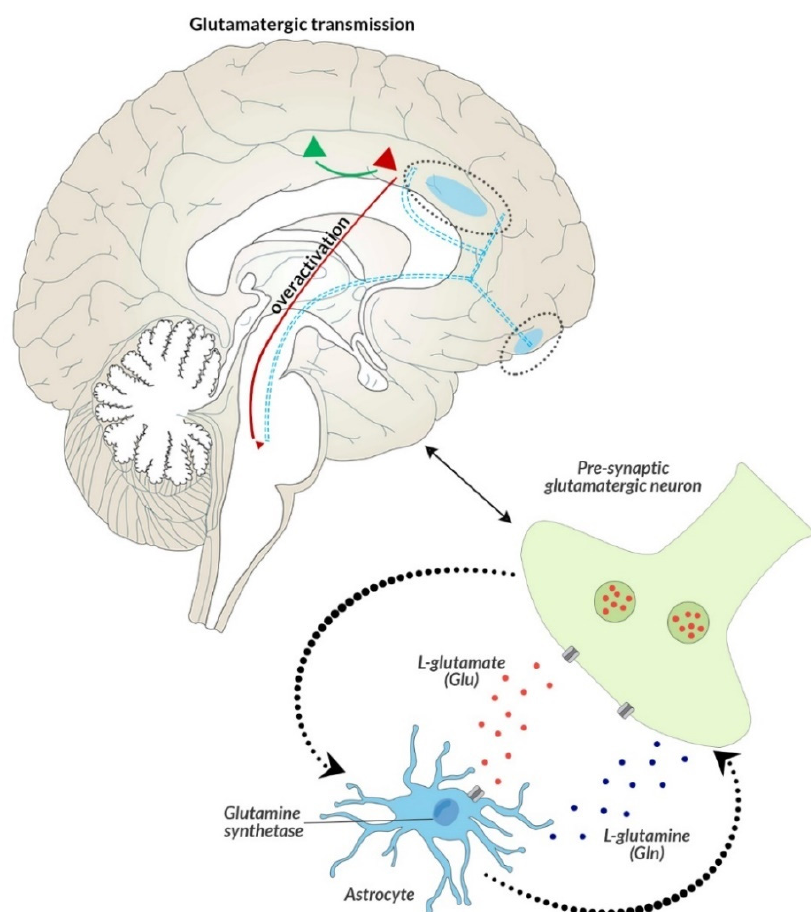
Figure 1. Potential mechanism explaining the occurrence of negative symptoms, and the developing resistance to classical neuroleptics due to the glutamatergic hypothesis and the NMDA receptor hypofunction. In addition to the glutamate projection pathway in the cortical brain stem, which is associated with the primary GLU neuron, the GABA interneuron, and the secondary GLU neuron, additional synapses in the midbrain with another GABA interneuron that targets neuronal DA projections that return to the frontal cortex, are involved in the projection of negative symptoms in schizophrenia. During normal psychiatric functioning, this circuit is balanced and sufficient DA reaches the frontal cortex without negative symptoms. However, when the pathway is modified with the formation of an additional GABA interneuron (originally: GLU-GABA-GLU-D; after modification: GLU-GABA-GLU-GABA-DA), this change might be associated with the appearance of negative symptoms. In the case of generating positive symptoms, glutamate from the primary GLU neuron reaches hypofunctional NMDA receptors located on the primary GABA interneuron, whose tone disappears in the absence of GLU stimulation and the secondary GLU neuron becomes hyperactive again. In contrast to the mechanism associated with the generation of positive symptoms, the main issue concerns the secondary GLU neuron, which hits another GABA interneuron, which, through a higher than normal GLU signal, releases much higher concentrations of GABA. This results in the inhibition of the final pathway of DA neurons derived from the midbrain and their lower release. This mesocortical DA pathway is now active and does not provide adequate amounts of DA in the frontal cortex, which causes hypofrontality and negative symptoms.